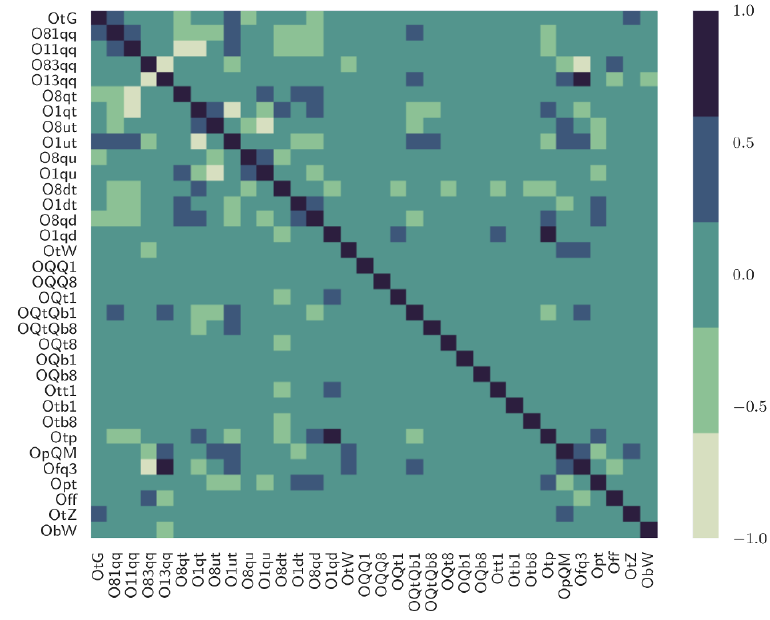
Figure 8 . The values of the correlation coe(cid:14)cient between the di(cid:11)erent degrees of freedom c eq. (4.11), for the L2 closure test with SM reference